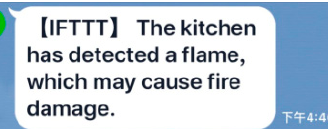
Figure 11. Notification messages on Line.